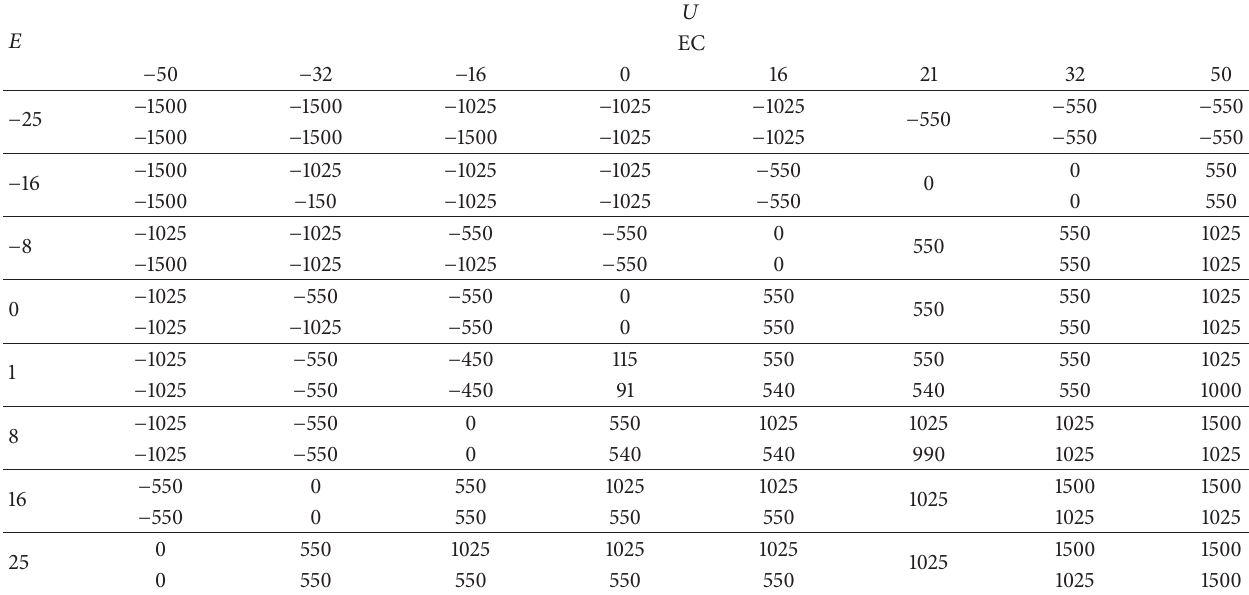
Table 5: The fuzzy control program running